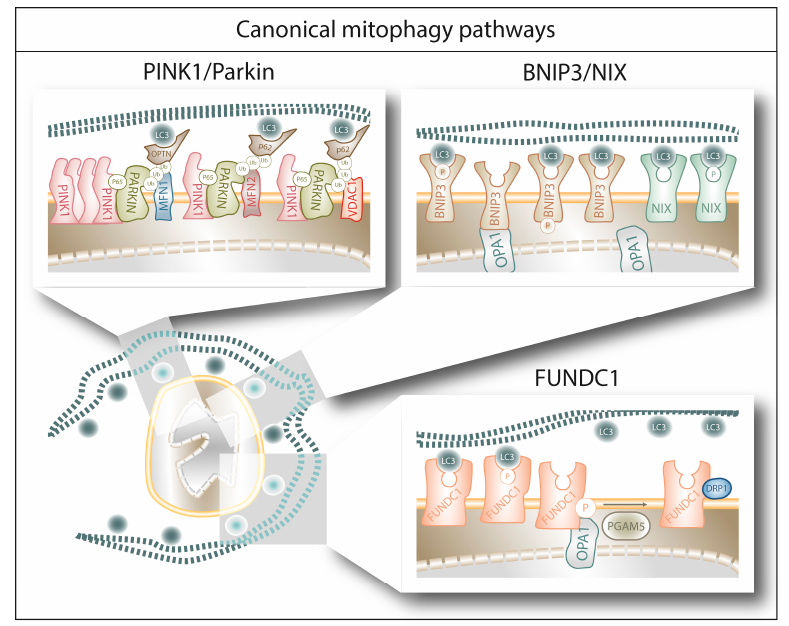
Figure 1. The figure schematically summarizes the main mechanisms and players of canonical mitophagy pathways upon autophagosome recognition of the di ff erent receptors in a damaged mitochondrion (see main text for further details). First, PINK1 / Parkin mediated ubiquitination of mitochondrial proteins enables the autophagy cargo receptors p62 and OPTN to bridge the mitochondria / autophagosome interaction. Alternatively, BNIP3, NIX and FUNDC1 can directly bind the LC3 molecules decorating the autophagosome, through a mechanism modulated by their phosphorylation